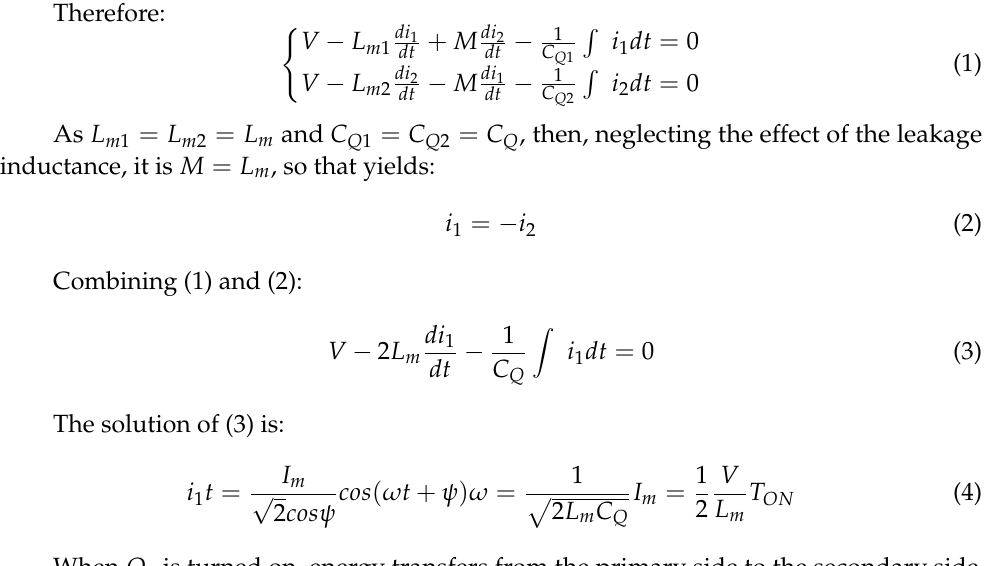
When Q 1 is turned on, energy transfers from the primary side to the secondary side, with the equivalent circuit diagram shown in Figure 6. In Figure 6, the green and blue arrows indicate the direction of current flow on the primary side, the red arrows indicate the direction of current flow on the secondary